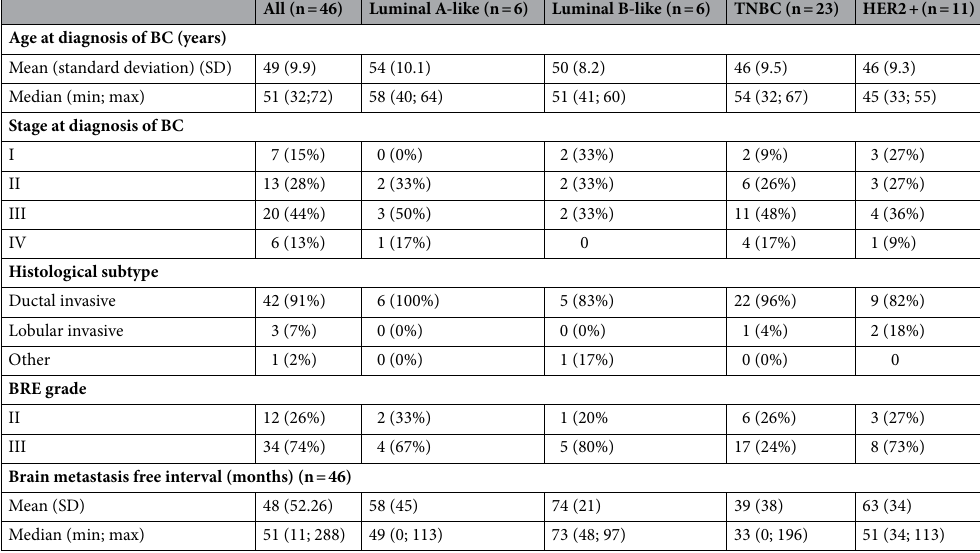
Table 1. Clinical characteristics at primary breast cancer of the 41 patients with available primary tumor material. BRE (Bloom–Richardson–Elston system, with 1–3 being grade I, BRE 4–7 grade II, and BRE 8–9 grade III.